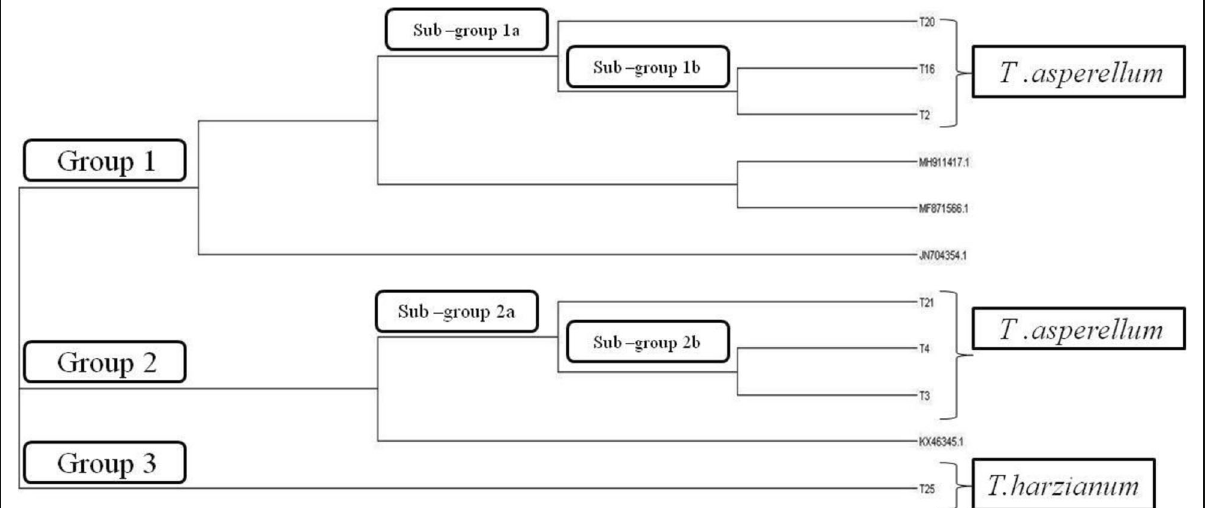
Fig. 3 Dendrogram showing similarity coefficient of seven Trichoderma isolates based on sequencing analysis